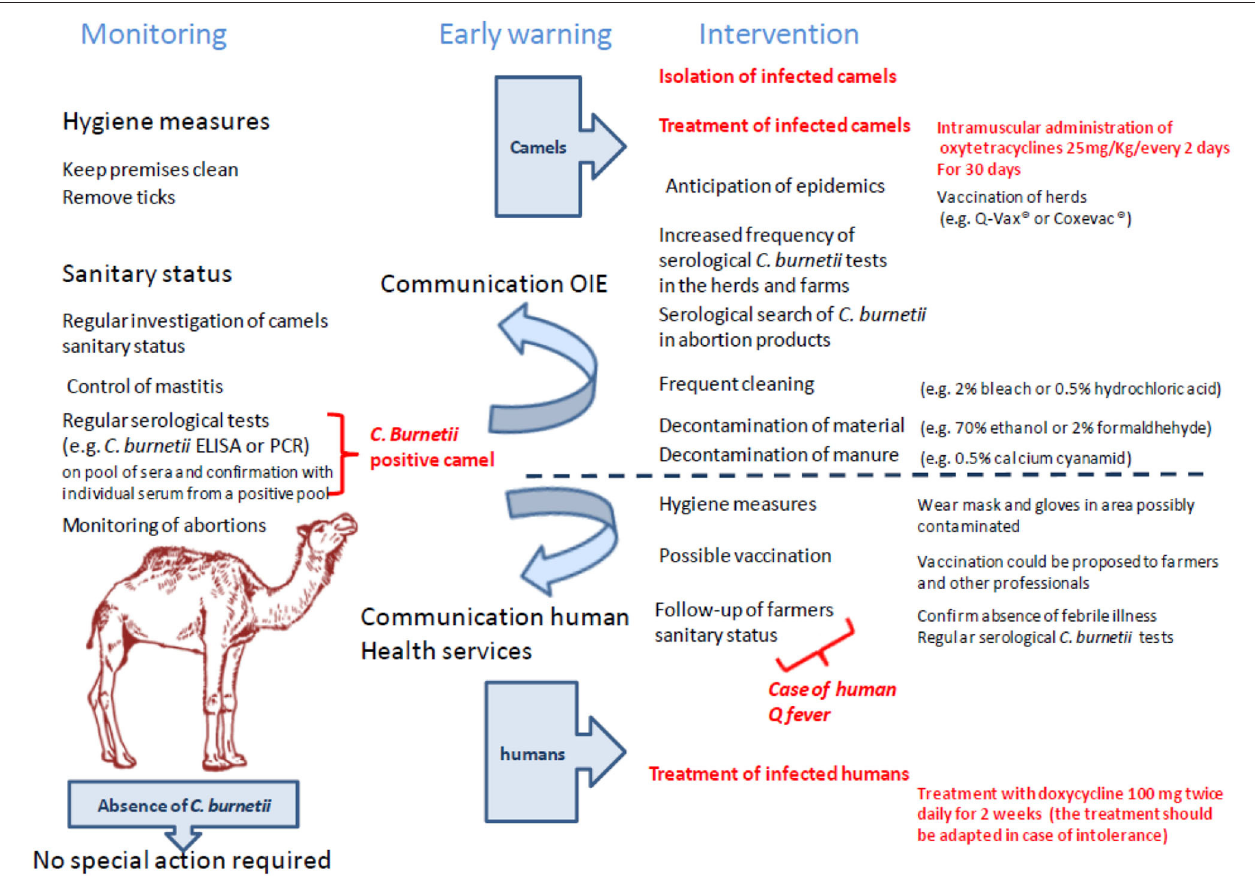
FIGURE 7 | Suggested flowchart to monitor farms against the risk of C. burnetii infection. This logigram takes into account the surveillance, the alert, and the measures to be taken in case of presence of C. burnetii –infected animals in a herd. With regard to the specific actions to be implemented, they relate to both general safety measures and specific measures for sick camels or herds with sick animals and